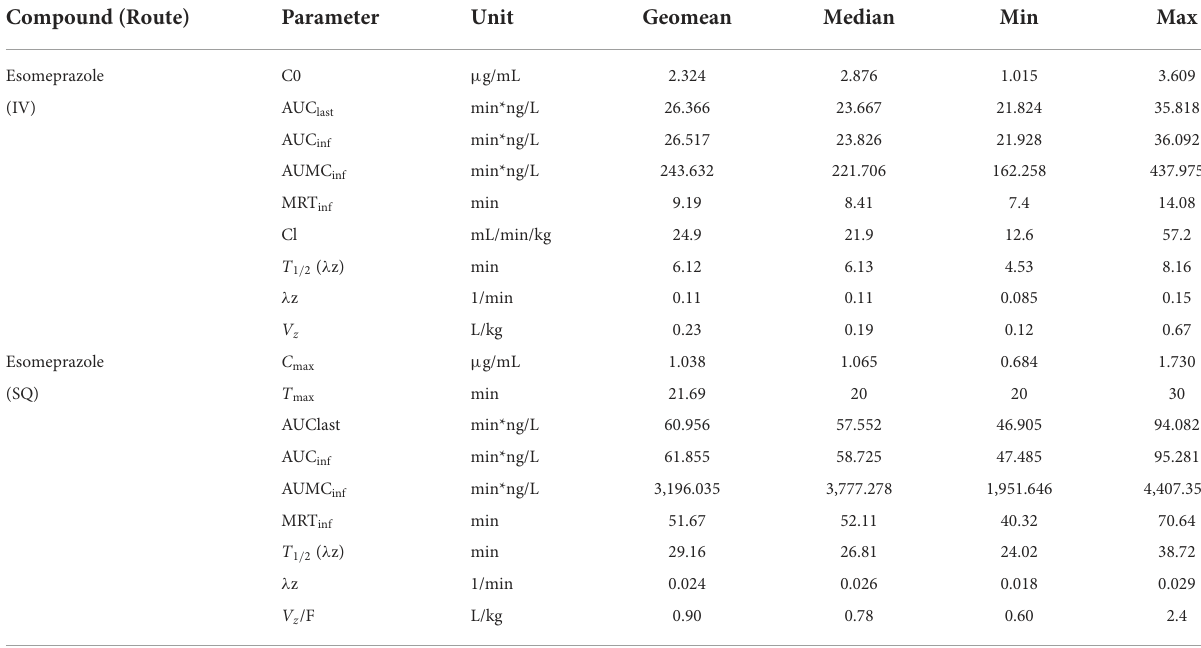
TABLE 1 Pharmacokinetic parameters of esomeprazole after single dose intravenous (IV: 1 mg/kg) and subcutaneous (SC: 2 mg/kg) administration in goats ( n = 5). Compound (Route)